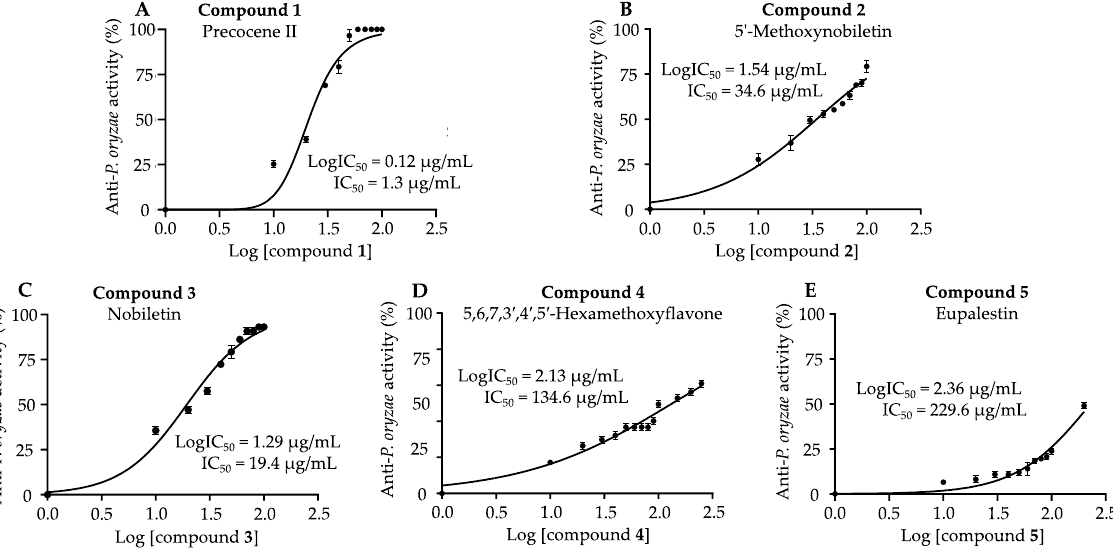
Figure 4. Antifungal activities of isolated compounds 1 – 5 ( A – E ) against the development of P. oryzae . P. oryzae was cultured for 7 days on PDA plates containing different concentrations of each compound in the range of 10–250 µ g/mL. Then, the diameters of mycelial growth area of fungi were measured and IC 50 values were calculated. PI (%) calculated was plotted vs logarithmic concentration of the compound. n = 3.